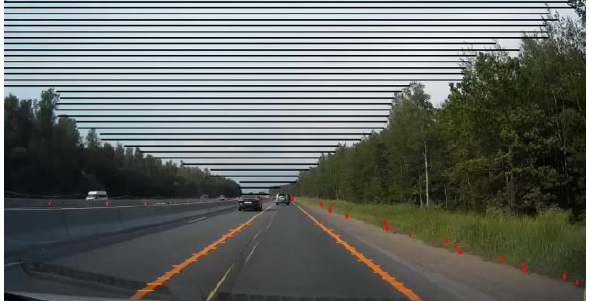
Figure 6 . Integrated analysis of a road